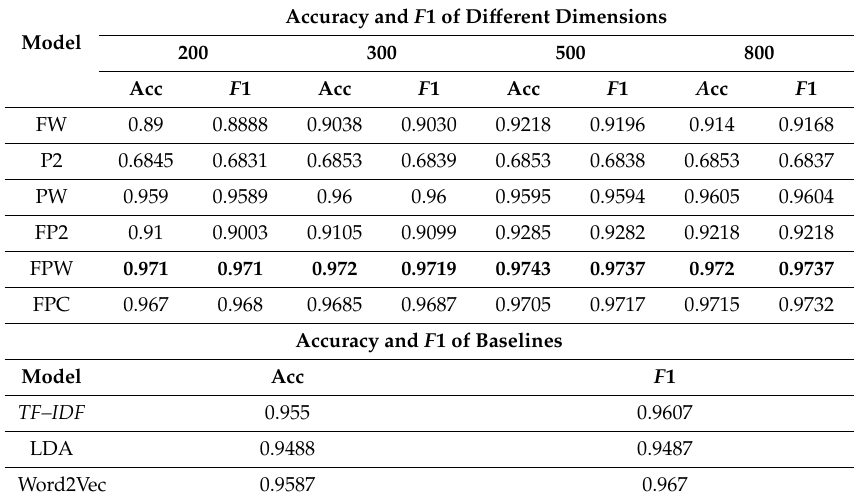
Table 2. Results of Amazon_6 in two classes for 4000 texts by support vector machine (SVM).